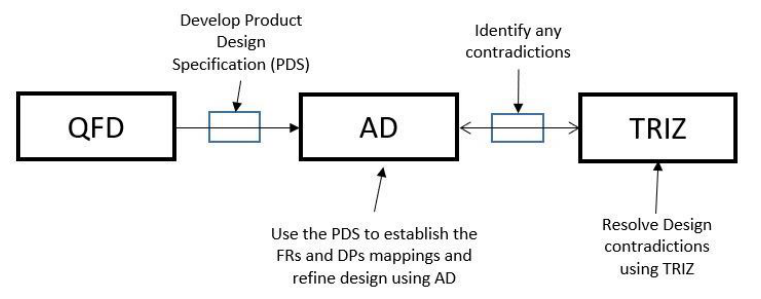
Figure 4. Integration of QFD, AD, and TRIZ